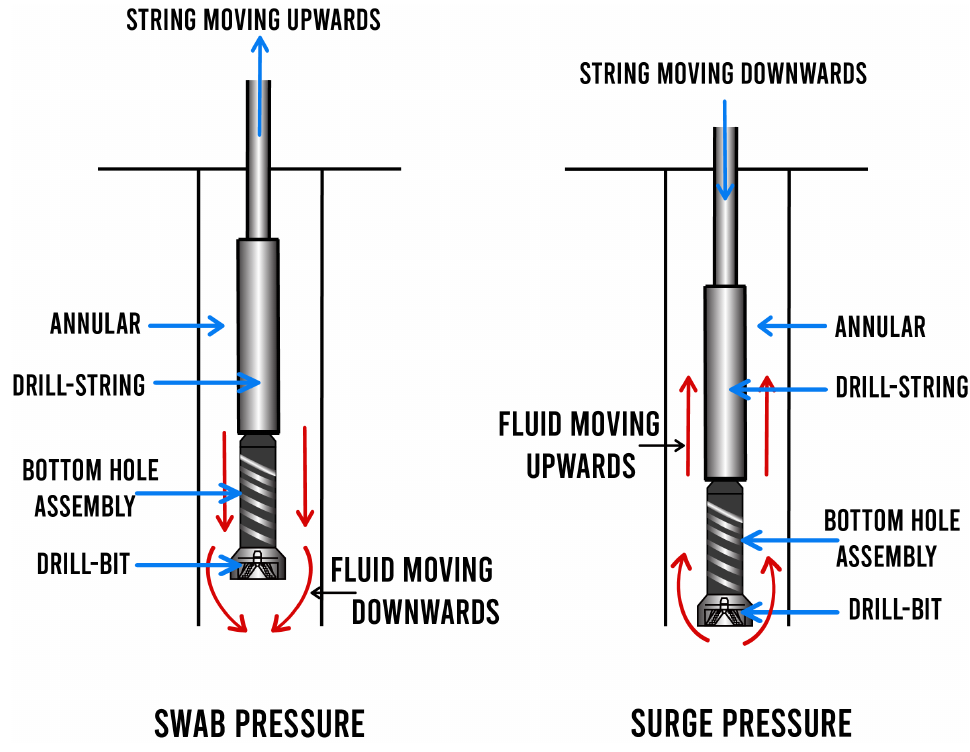
Figure 1. Swab and surge pressure